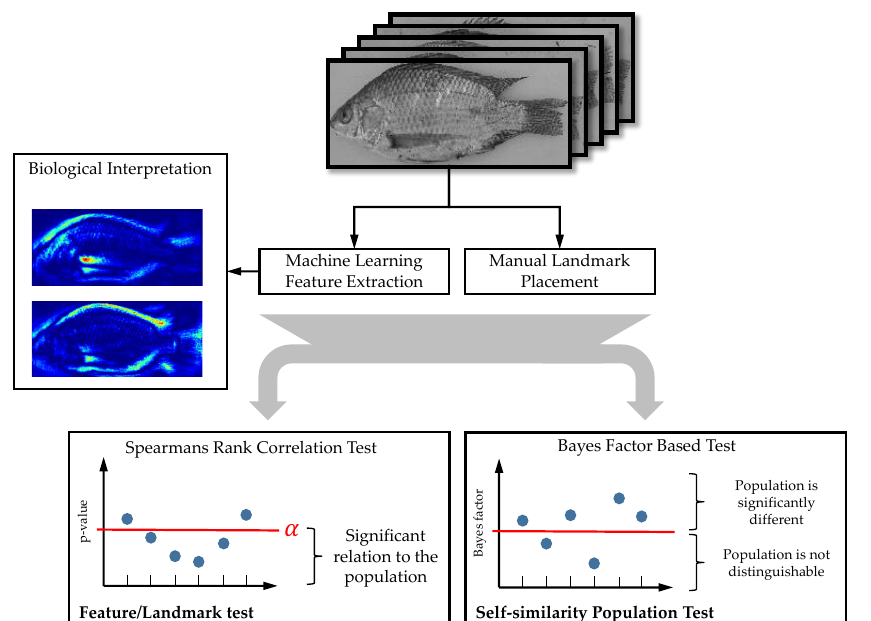
Figure 2. The pipeline used in this study to investigate the biological interpretation of the learned features as well as the statistical analysis of the discriminability of the known population clusters. Table 1. Summary of image dataset from Ethiopia (209 specimens) and Uganda [5] (462 specimens). During this study, we used the location name as well as the abbreviation. Water Body Abbr. Nr. Spec.